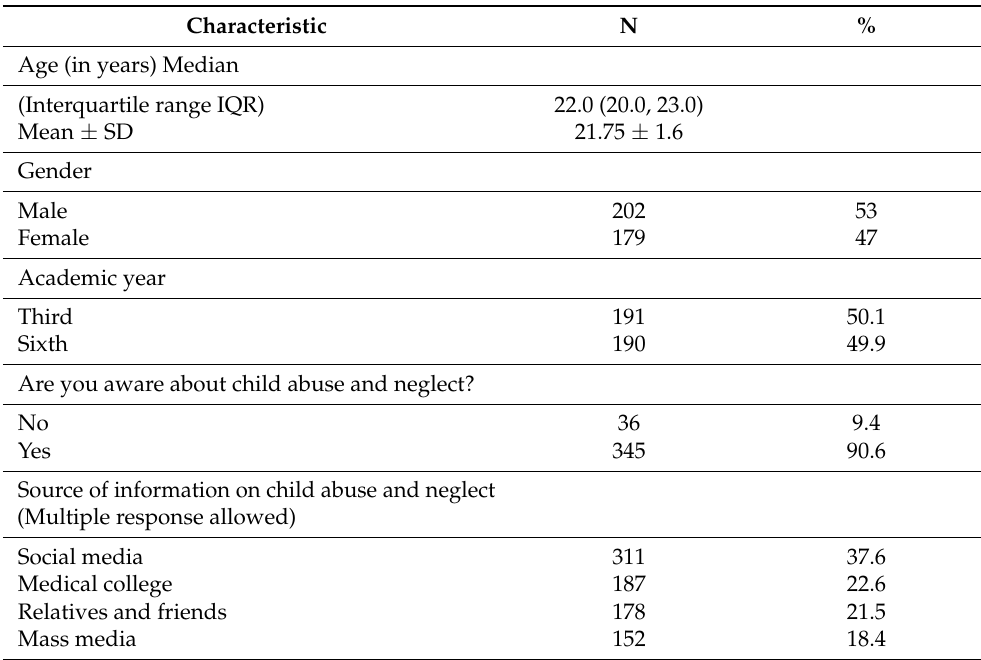
Table 1. Demographic Details of the Participants and Awareness on Child Abuse and Neglect.